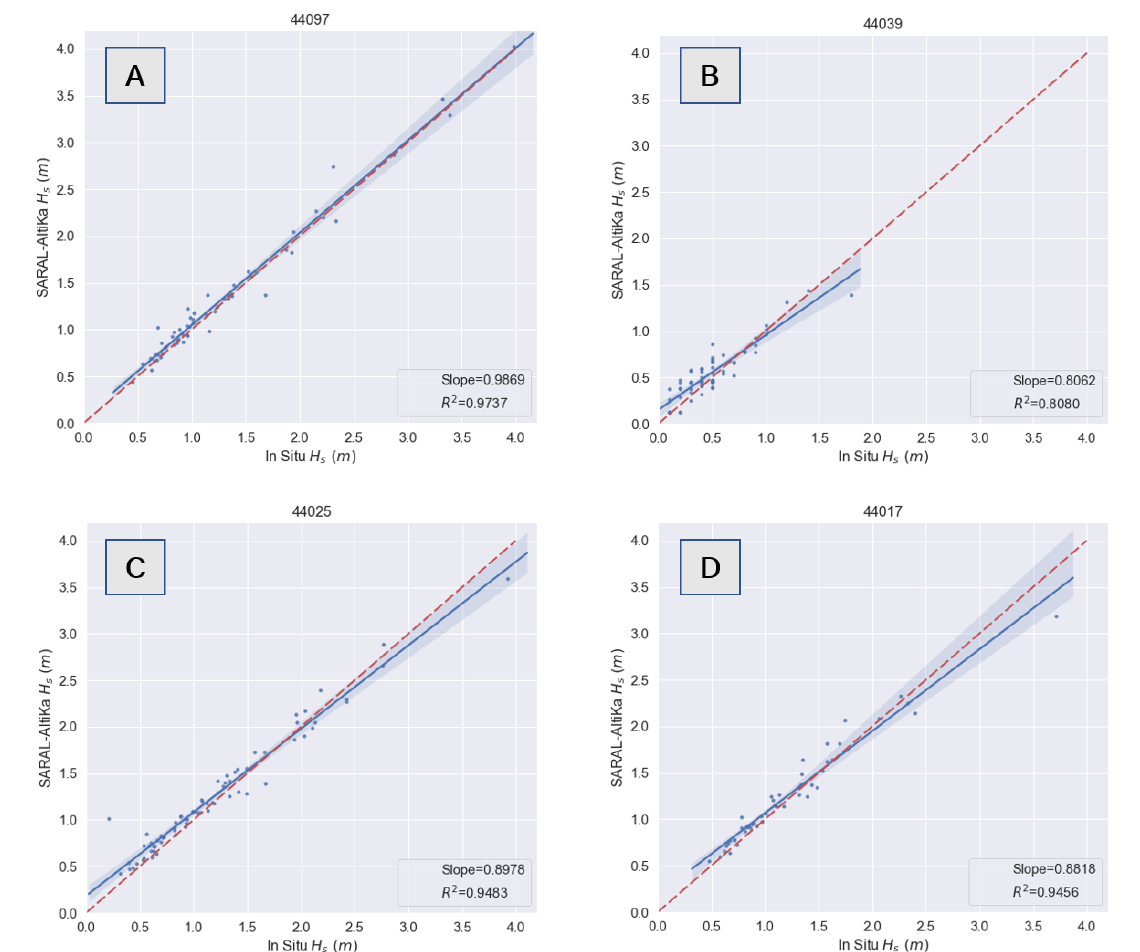
Figure 3. Comparison of significant wave height, H s , between SARAL/AltiKa and selected buoys at stations 44097 ( A ), 44039 ( B ), 44025 ( C ), and 44017 ( D ). Matched measurements denoted as blue dots are those falling within radius R p 25 . In each case, the fitting linear regression line is shown as a continuous blue line with their corresponding 99% confidence interval in shaded blue.